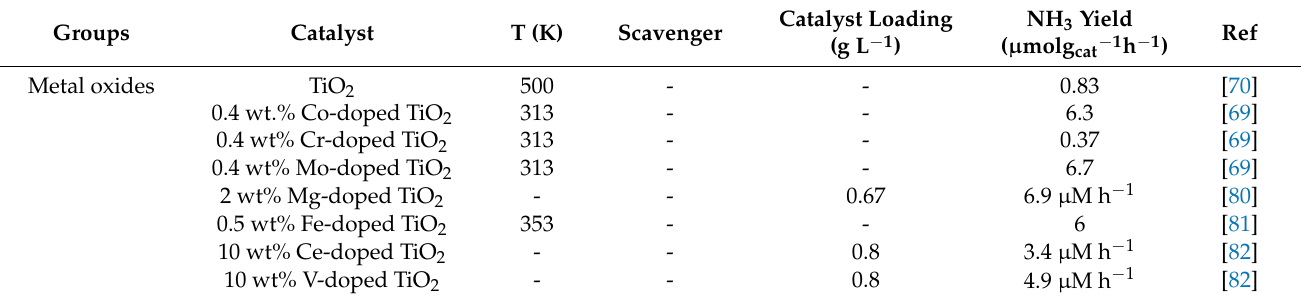
Table 7. Recent studies on photochemical catalysis systems for ammonia production.